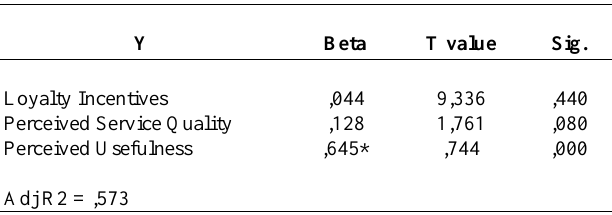
Table 4: Multiple regression of loyalty, perceived